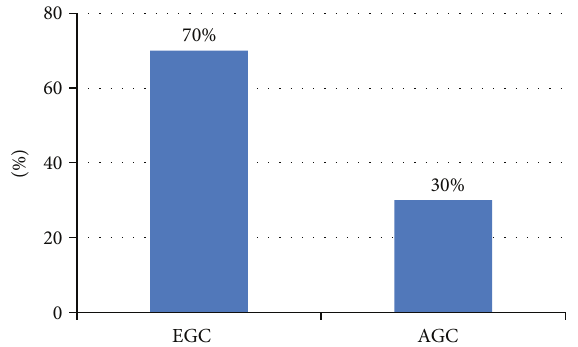
Figure 3: Proportion of early gastric cancer and advanced gastric cancer among gastric cancer diagnosed through National Cancer Screening Program from October 2005 to April 2012. EGC: early gastric cancer; AGC: advanced gastric